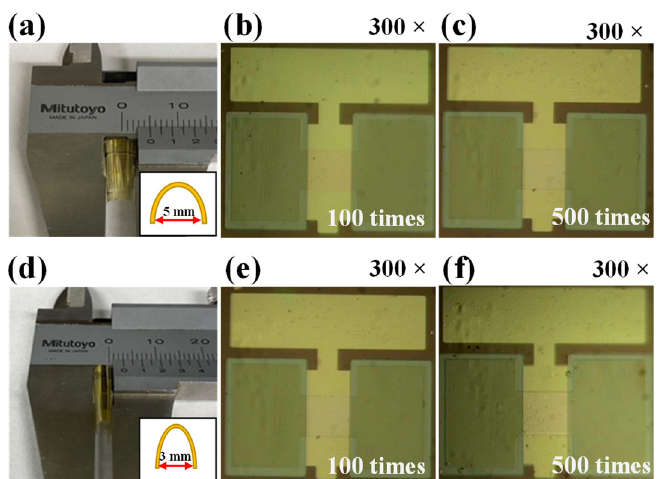
Figure 9. Polyimide substrates on which sol-gel composite-based synaptic transistor devices were formed using vernier calipers bent to ( a ) 5 mm and ( d ) 3 mm in diameter. Optical microscopy images of the sol-gel composite-based synaptic transistor devices after ( b ) 100 times and ( c ) 500 bending tests with a diameter of 5 mm, and after ( e ) 100 times and ( f ) 500 times bending tests with a diameter of 3 mm.